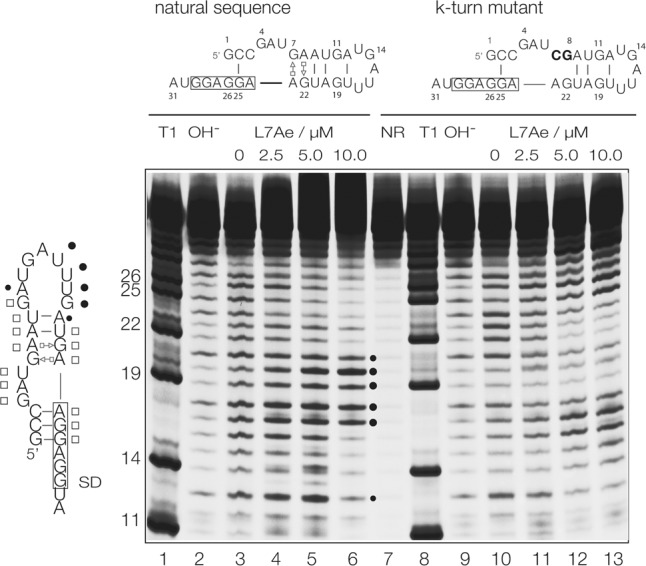
Analysis of conformational change in the A. fulgidus 5′-UTR RNA induced by the binding of AfL7Ae protein using in-line probing (Soukup and Breaker 1999). The sequences of the two RNA species studied are shown at the top, drawn in their potential stem–loop conformations. The boxed regions are the ribosome binding site. The mutant sequence (right) has two sequence changes (highlighted in bold) in the G:A base pairs that will prevent k-turn formation. Tracks 1 and 8 contain RNA cleaved by T1 nuclease that cuts 3′ to G nucleotides to provide a reference frame (sequence positions shown on the left). Tracks 2 and 9 contain natural-sequence RNA subject to hydroxide cleavage to generate cleavage through the RNA. Track 7 contains RNA not subjected to any degradation procedure, i.e., full-length RNA. Tracks 3 through 6 and 10 through 13 contain the results of in-line probing in the presence of 0, 2.5, 5, and 10 µM AfL7Ae for natural and mutant RNA, respectively. The black circles drawn on the fluorogram denote positions of reactivity in the natural 5′-UTR RNA in the presence of L7Ae. The schematic on the left shows the sequence of the natural 5′-UTR drawn in its stem–loop conformation. Filled circles denote positions of reactivity and open squares denote positions of protection, both in the presence of L7Ae.